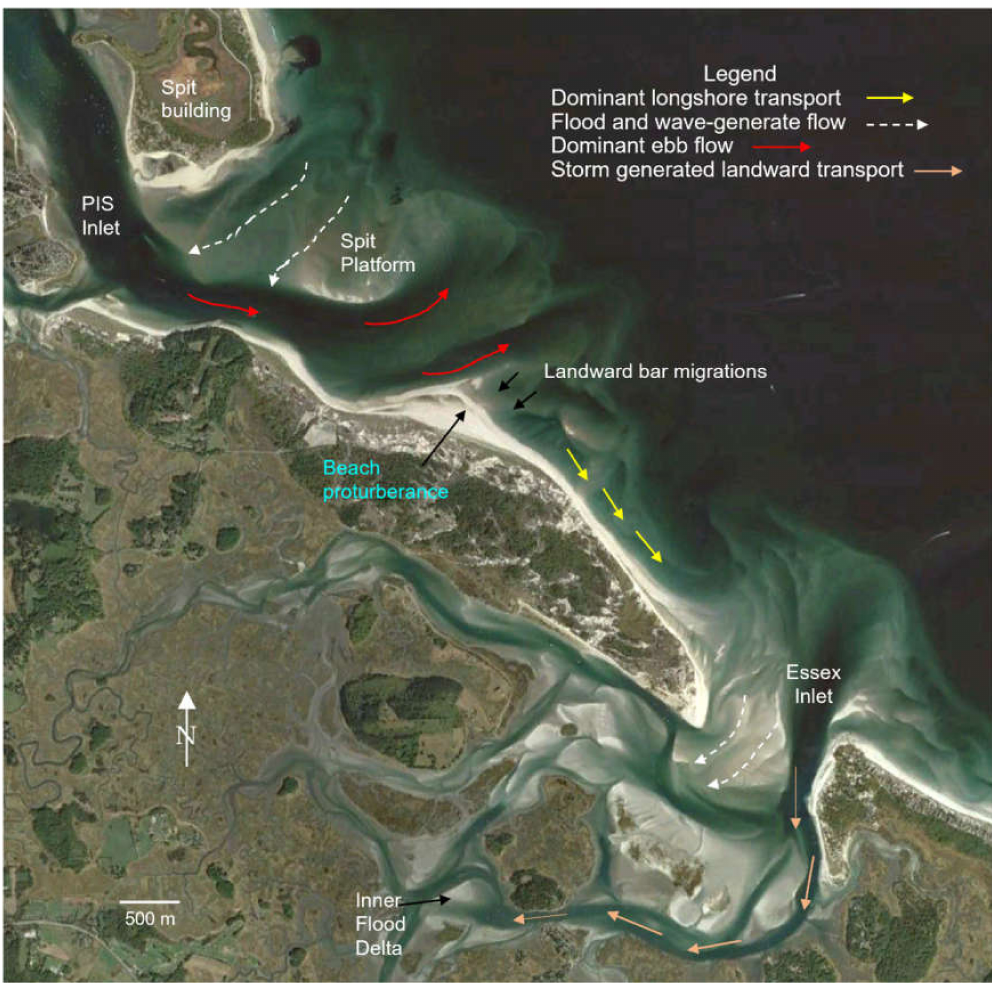
Figure 15. Conceptual model of sand transport pathways at the study area. This conceptual diagram traces the pathway of sand transport from southern Plum Island to Essex Bay. A description of the mechanism and sand reservoirs is described in the